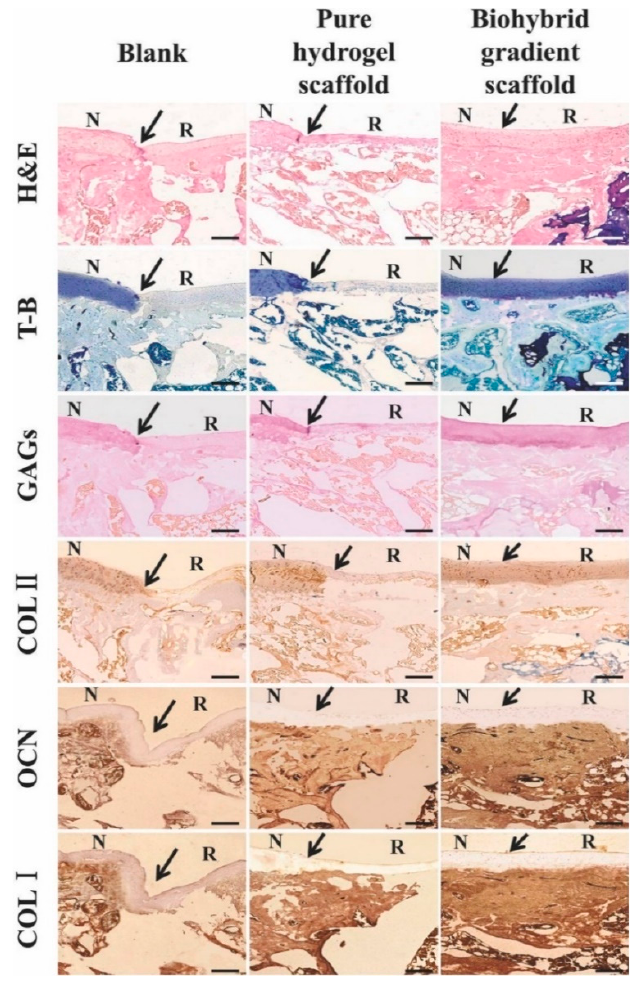
Figure 12. Histological analysis of 3D printed implants 12 weeks after surgery and scaffold implantation in rat OC defects. H&E and toluidine blue (T-B) staining demonstrated that the TGF- β 1/ β -TCP scaffold (biohybrid gradient scaffold) improved tissue repair and organisation, compared with pure hydrogel scaffolds and no scaffold (blank). The content of GAGs, as assessed by Periodic-Acid Schiff (PAS) staining, and type II collagen, determined by immunohistochemistry, was additionally improved by the biohybrid scaffold. SB formation was also observed, with higher osteocalcin (OCN) and type I collagen contents in the groups treated with the biohybrid scaffold. N—normal cartilage; R—repaired cartilage; black arrows indicate the interface between normal and repaired cartilage. Scale bars: 200 μ m. Reprinted with permission from [332]. Copyright © 2018, WILEY-VCH Verlag GmbH and Co. KGaA, Weinheim.